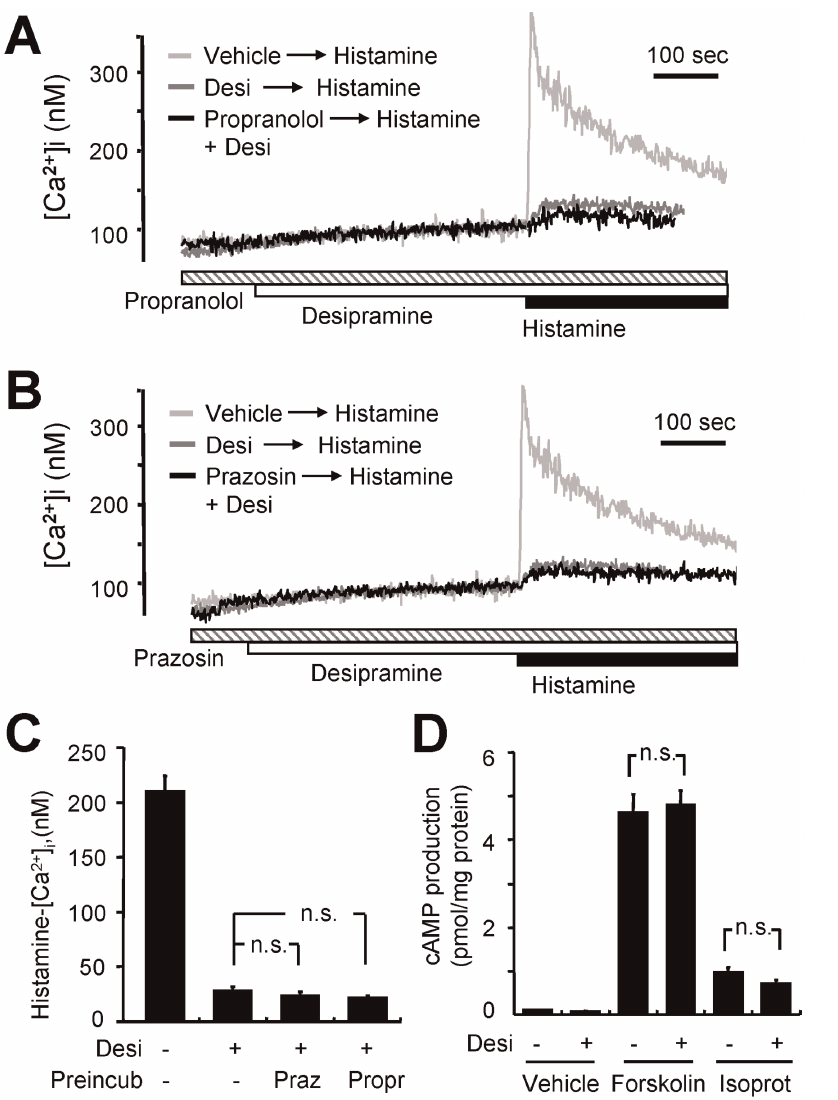
Figure 4. Propranolol and prazosin did not reverse desipramine-mediated inhibition of histamine-induced [Ca 2 + ]i rise in GT1-1 cells. (A) Fura-2-loaded GT1-1 cells were preincubated with (black trace) or without (gray trace) 30 m M propranolol and then challenged with 30 m M desipramine (Desi) and 100 m M histamine, sequentially. The histamine-induced [Ca 2 + ]i increase without any drug pretreatment is depicted as control (light gray trace). Typical [Ca 2 + ]i traces from more than seven separate experiments are presented. (B) Cells were preincubated with (black trace) or without (gray trace) 30 m M prazosine and then challenged with 30 m M desipramine (Desi) and 100 m M histamine sequentially. The histamine-induced [Ca 2 + ]i increase without any drug pretreatment is depicted as a control (light gray trace). Typical [Ca 2 + ]i traces from more than seven separate experiments are presented. (C) The net increases in histamine-induced [Ca 2 + ]i in A and B with 30 m M desipramine (Desi), 30 m M prazosine (Praz), and 30 m M propranolol (Propr) is depicted with the mean 6 SEM. The experiment was independently performed three times. (D) Cells were stimulated with 3 m M forskolin, 30 m M desipramine (Desi), or 1 m M isoproterenol (Isoprot) in the presence of 5 m M Ro 20–1724 for 15 minutes; cAMP production was then monitored. The cAMP levels were measured. Each point is the mean 6 SEM of a triplicate assay. The data are representative of three separate experiments. All results were reproducible. n.s., not statistically significant with P . 0.05.